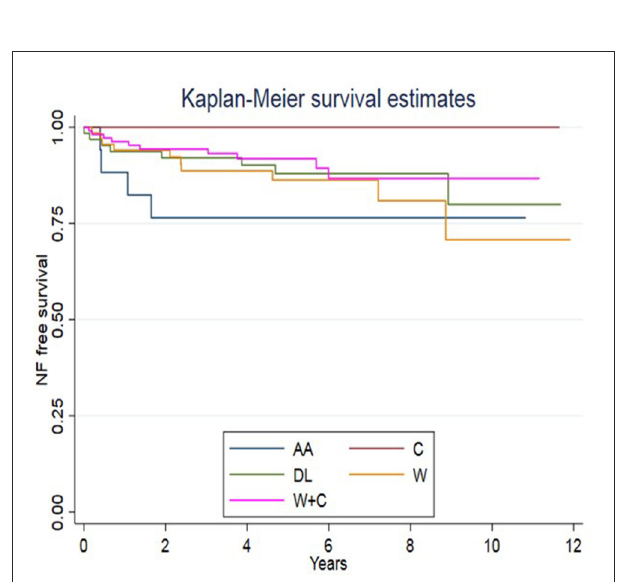
FIGURE3 Types of formula and switch assumed in our cohort. At baseline, 76 children were fed with a free diet (homemade blenderized feeds), 24 casein, 139 whey + casein, 46 whey, and 24 amino-acid-based